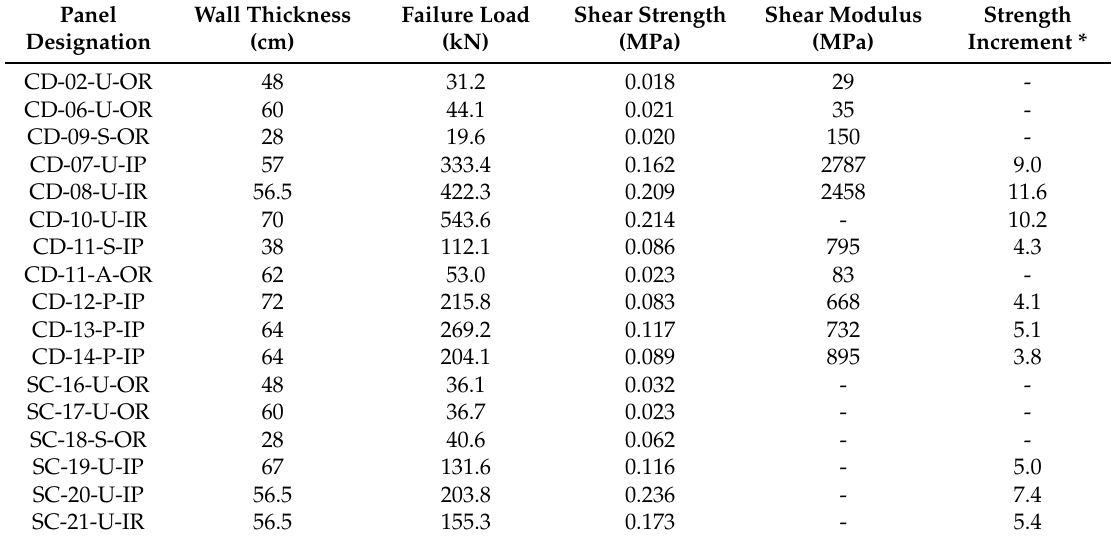
Table 1. Tests on wall